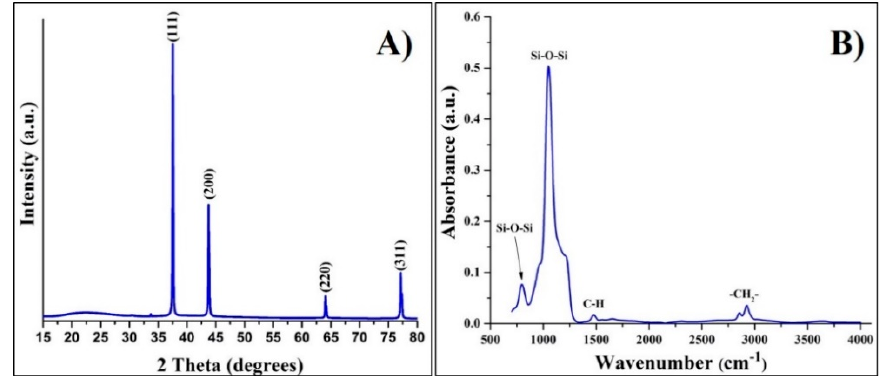
Figure 2. ( A ) XRD and ( B ) FTIR analysis of MSN/Ag nanocomposite.